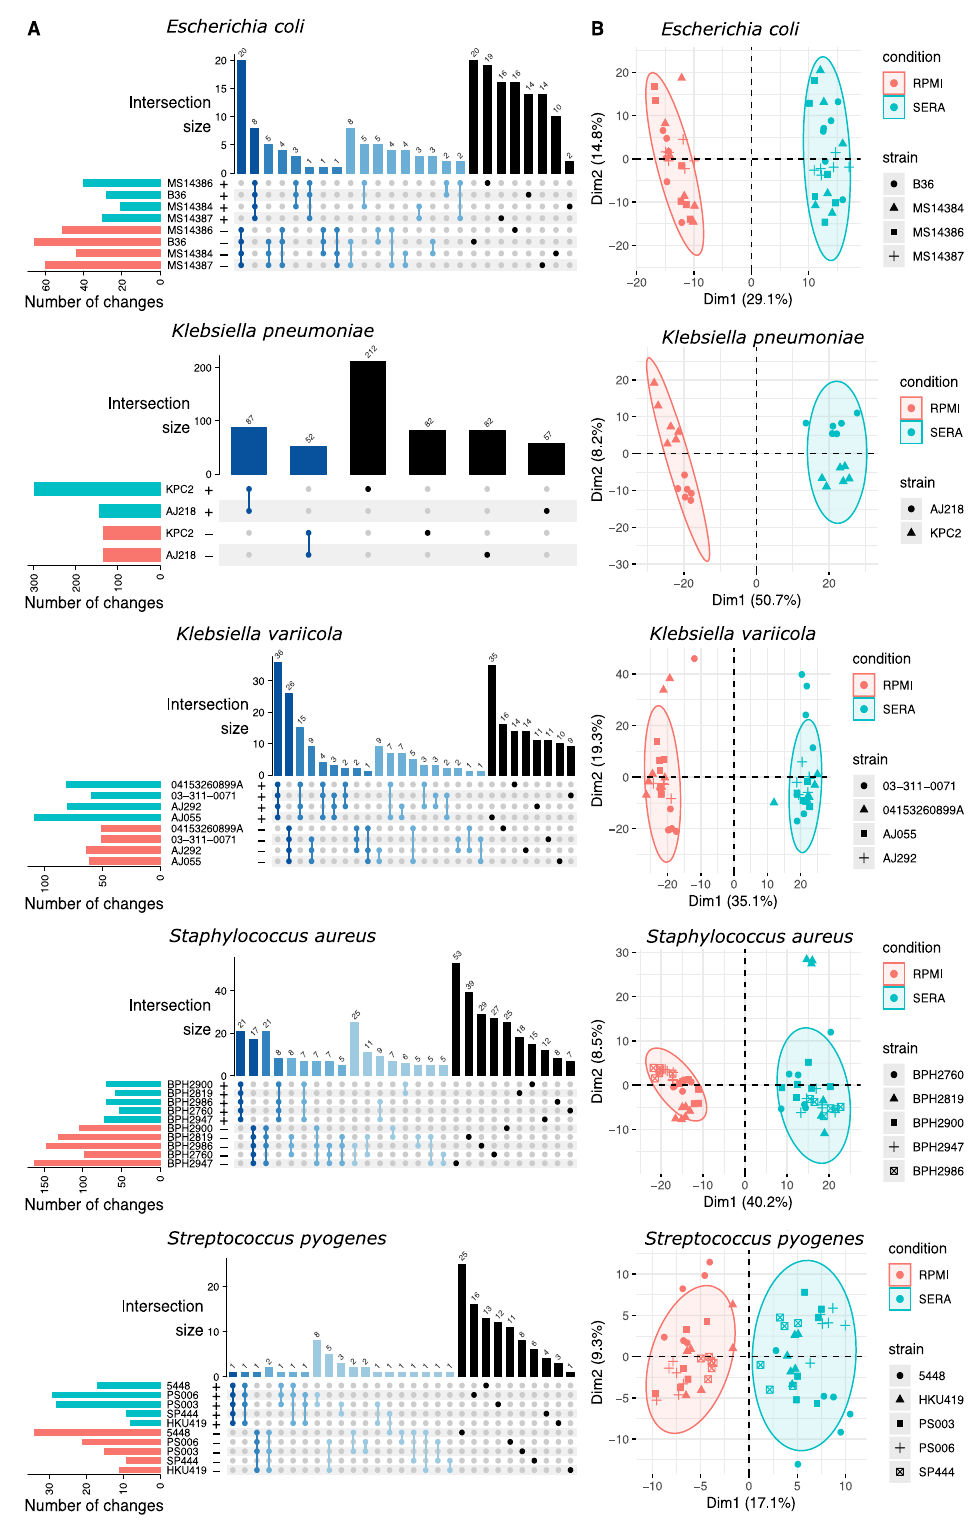
Fig. 5 | DDA mass spectrometry toassessthe impact ofserumexposure onthe proteomewithin thedifferentspecies.A UpSetplotrepresentingthe sharedand distinctive proteome responses across strains of the same species. Only proteins with signi fi cant differential abundance after exposure to human serum are